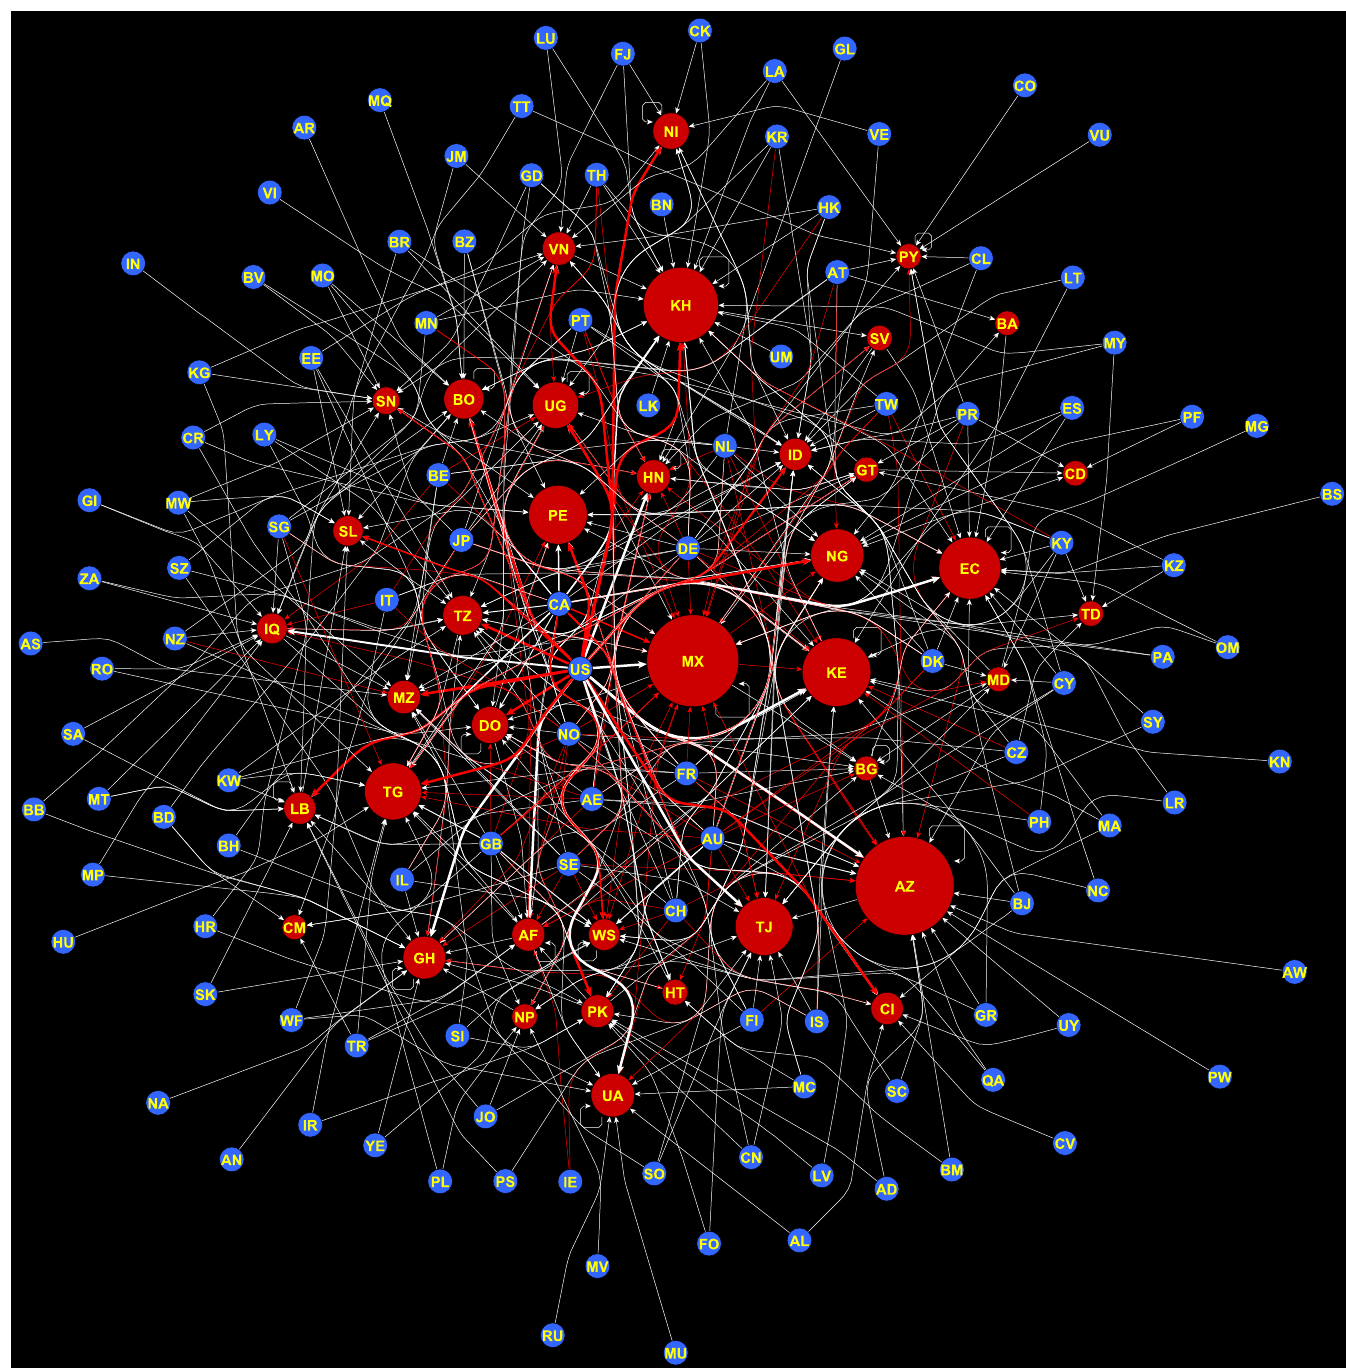
Fig 1. Biased links in the Kiva network. Visualization of positively (colored white) and negatively (colored red) biased links in the Kiva co-country network for 2007. Borrower countries (nodes) are shown in red with size proportional to the total transactions received by that country; whereas, lender countries are shown in blue and all nodes are of the same size. The link thickness corresponds to the actual number of transactions made between the country–pairs (more visualizations from the same year are shown in SI).